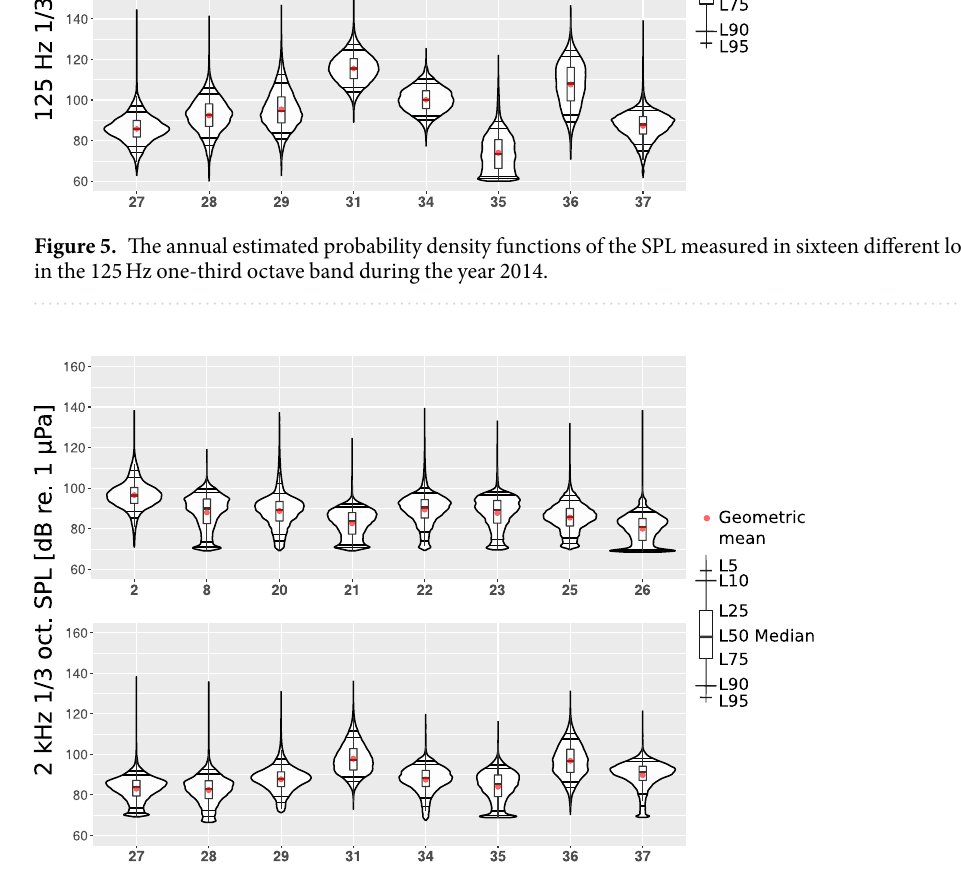
Figure 6. The annual estimated probability density functions of the SPL measured in sixteen different locations in the 2 kHz one-third octave band during the year 2014.